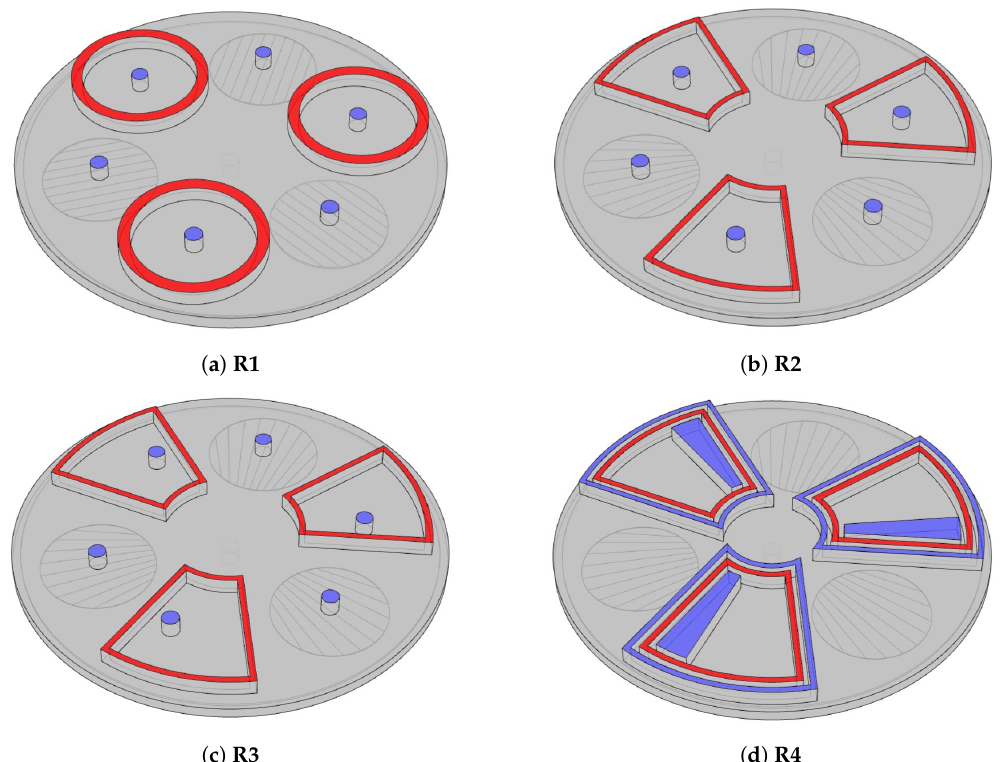
Figure 5. Four types of spatial, rotary ASALD reactor models with various inlet and outlet geometries (ring or annular sector) and positioning (symmetric or asymmetric) of reagent inlets. Red and blue areas indicate the outlets and inlets, respectively. 3 wafers are placed at the bottom inside the